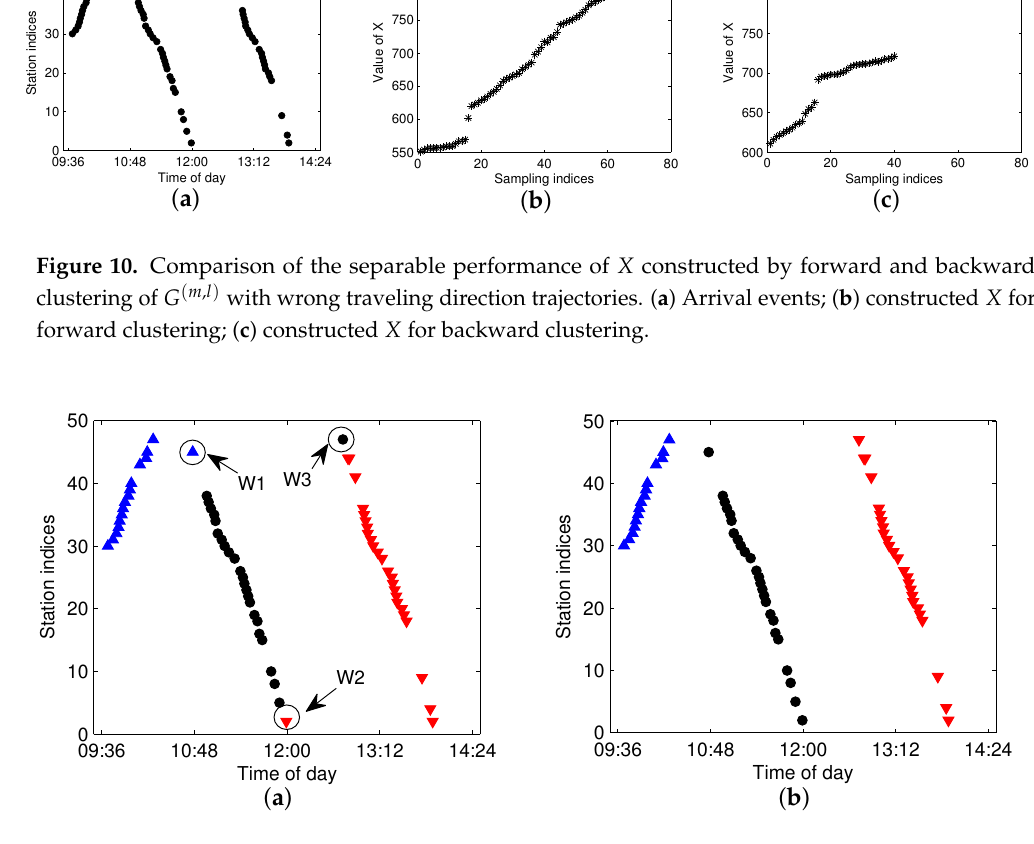
Figure 11. The comparison of the aggregated clusters by both forward FCM (F-FCM) and backward FCM (B-FCM). ( a ) Clustering by F-FCM; ( b ) clustering by